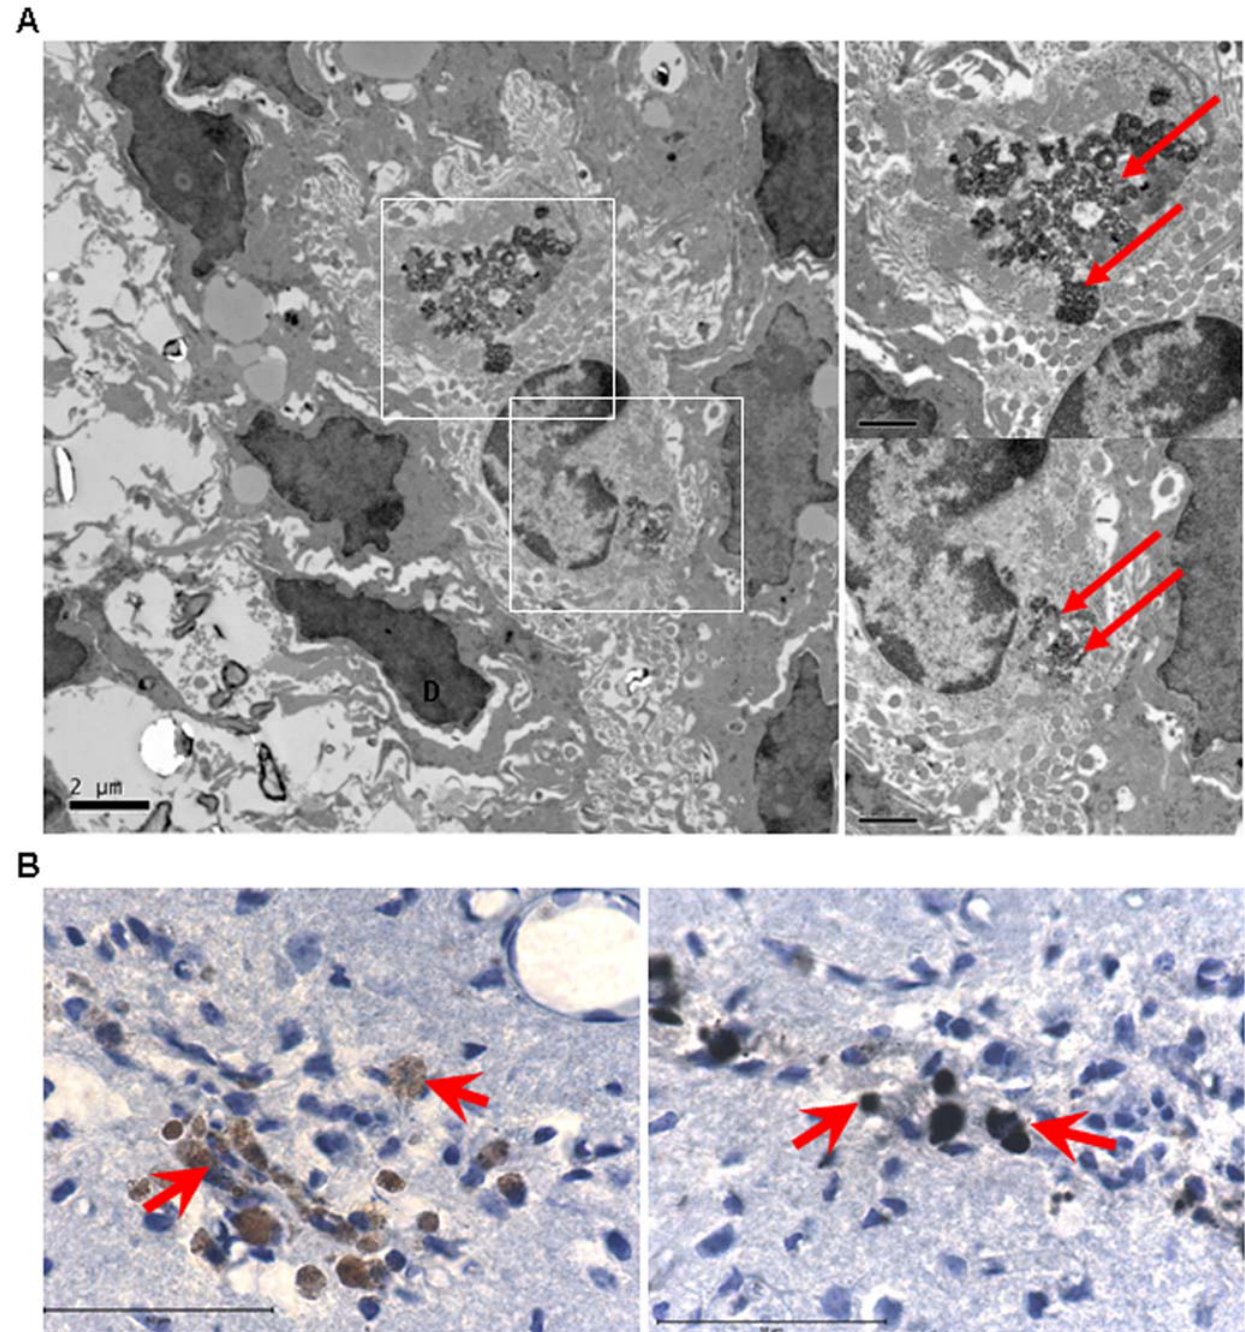
Figure 6. Retention of FE-Pro complex within labeled NSCs after implantation in tumor-bearing mice. (A) Electron micrograph of mouse brain that received intra-tumoral NSC administration (left). On the right are higher magnification images of the outlined areas in (A) (top and bottom). The FE-Pro complex is shown as an electron-dense iron label within the cells (solid boxes, A; red arrows, B). This is comparable to the morphology of encapsulated iron label in labeled NSCs in vitro (Fig. 2B). (B) Light microscopy images of huMito-positive cells (migrated FE-Pro- labeled NSCs and U251 cells) at the tumor site (B left, red arrows) , and huMito and Prussian blue double-stained FE-Pro-labeled NSCs in parallel sections (B right, red arrows) . Scale bars=2 m m (A left) , 1 m m (A right) and 50 m m (B) .